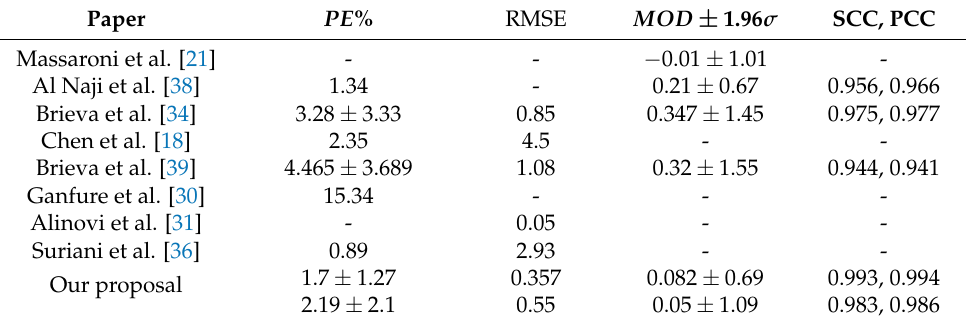
Table 12. Metrics to evaluate the estimation of the